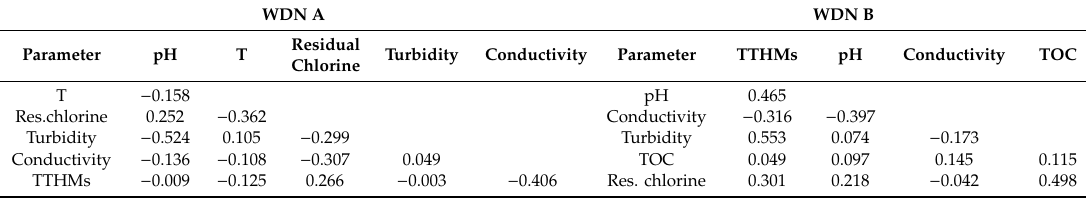
Table 4. Pearson correlation values for the parameters of both WDNs.